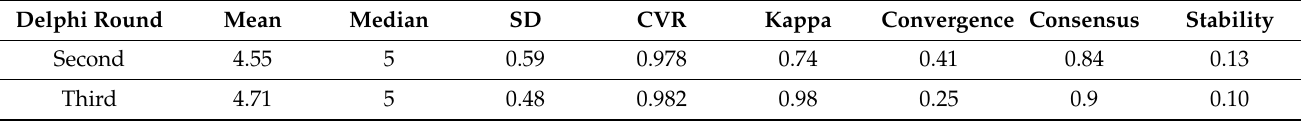
Table 3. Comparison of the results of the second and third rounds of the Delphi survey (N = 15).